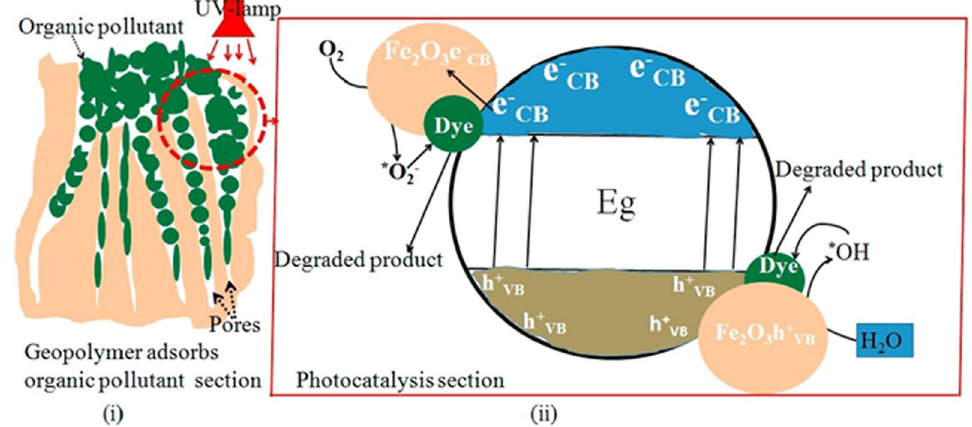
Fig. 30 Photocatalytic properties of geopolymer for degradation of dyes (Rasaki et al.